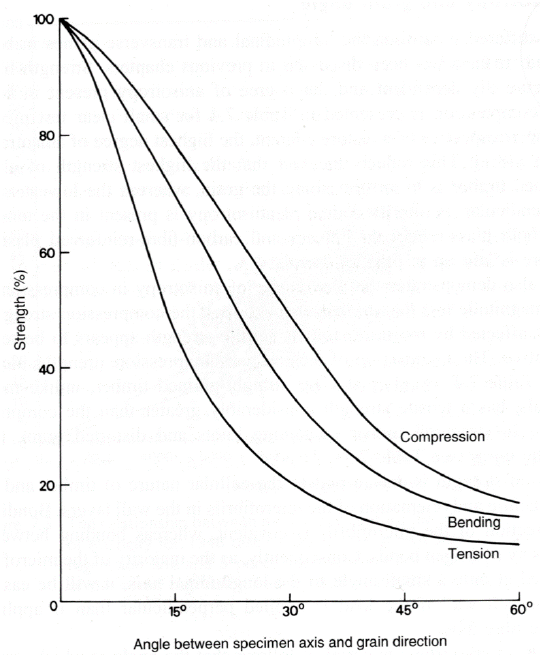
Figure 37. Effect of grain angle on the tensile, bending and compression strengths of timber. From [89].